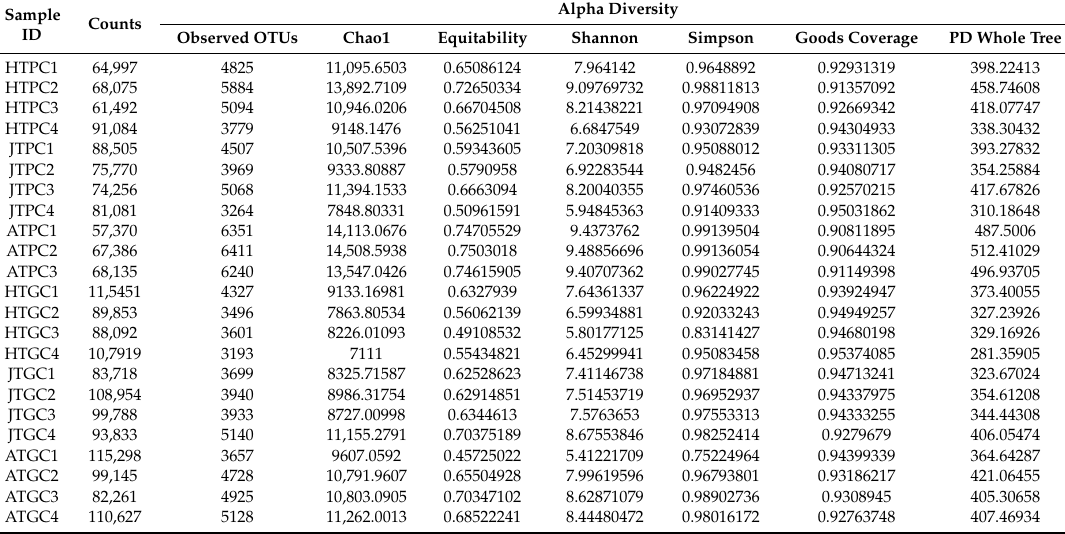
Table 2. Richness and diversity indexes relative to each sample (operational taxonomic units (OTUs) were defined at the 97% similarity level (Threshold is